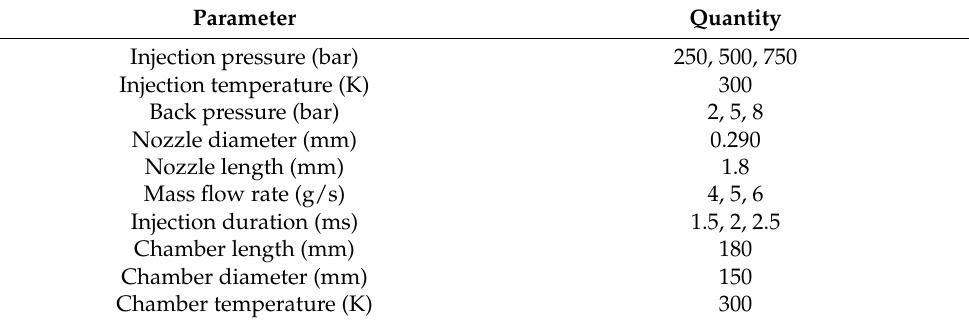
Table 1. Injection parameters for spray analysis.